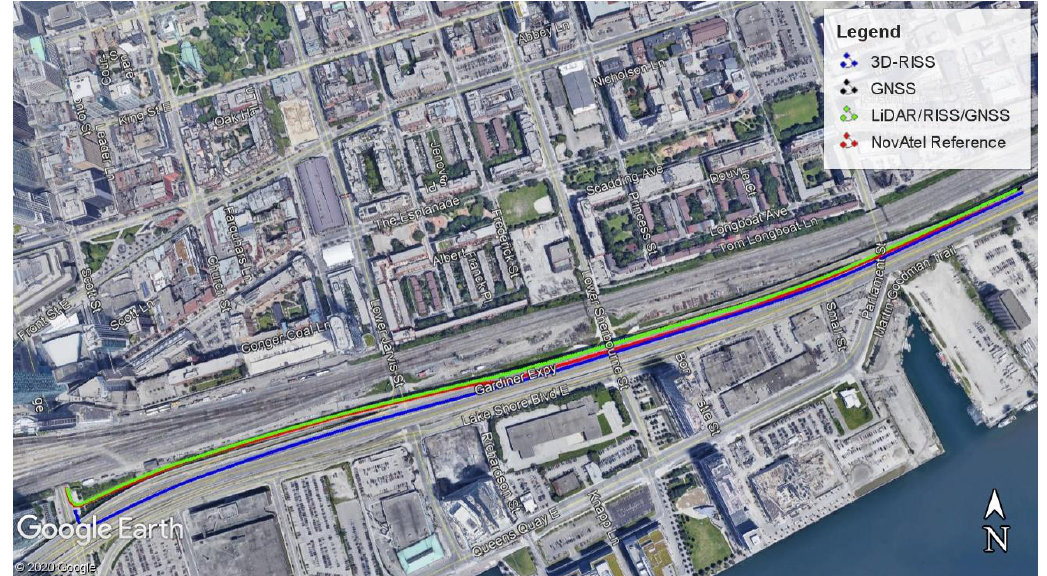
Figure 26. Navigation solution for 3D-RISS, GNSS, LiDAR/RISS/GNSS, and NovAtel reference at the Beginning of the Scenario.